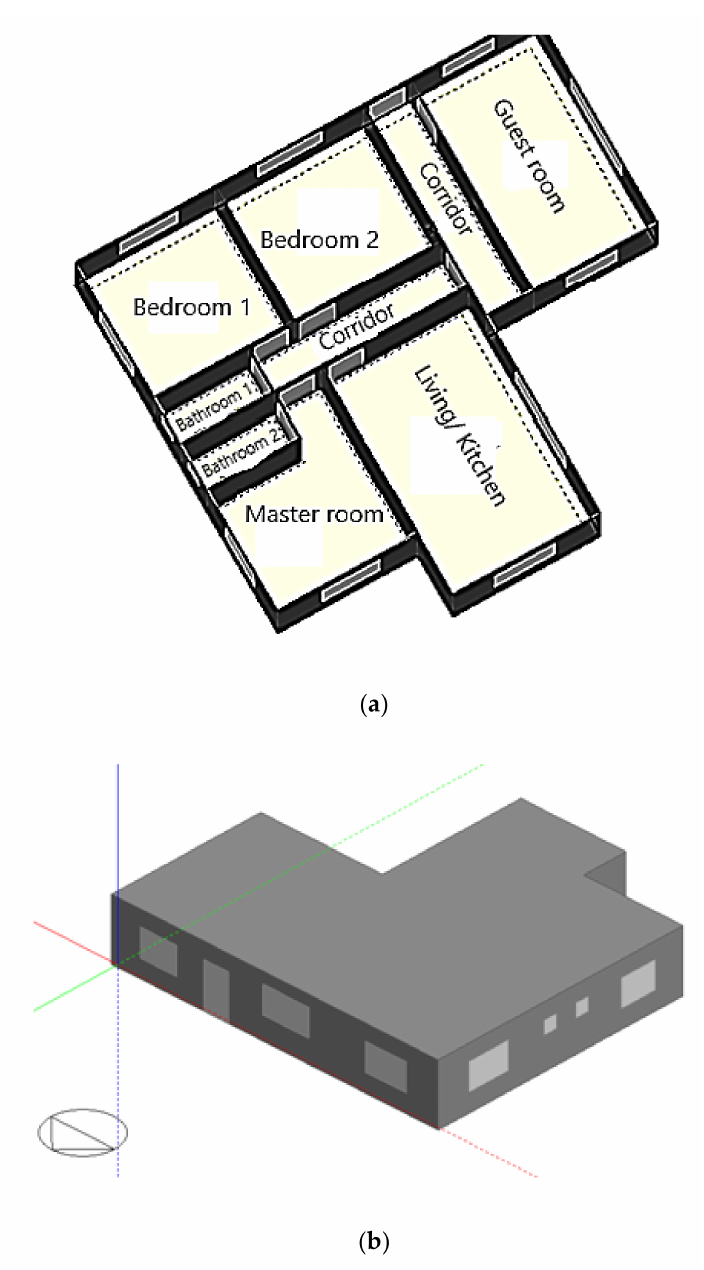
Figure 2. The schematic design of the house ( a ) building layout, ( b ) 3D building